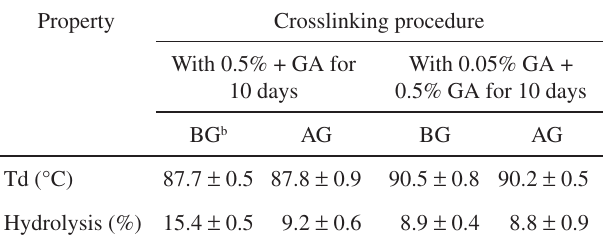
Table 2. Denaturation temperature and stability to collagenase hydrolysis a of bovine pericardium crosslinked with glutaraldehyde under different condi- tions, with or without the exposure to glutamic acid/borate buffer.